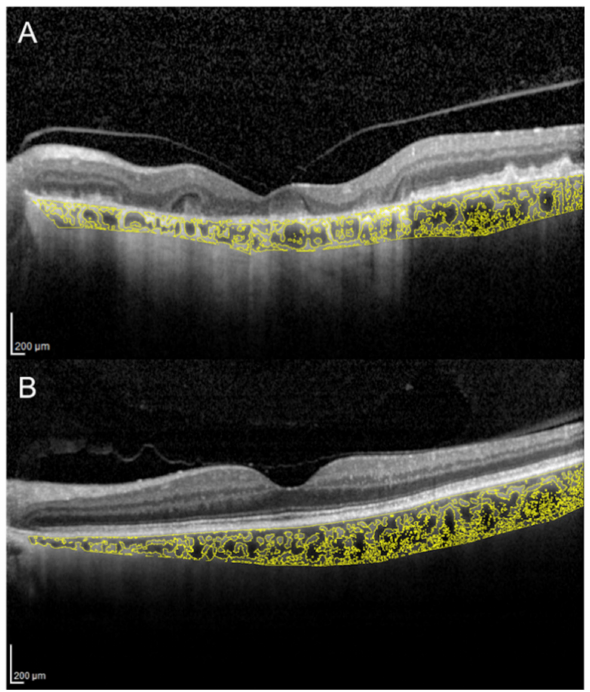
Figure 4. Choroidal vascularity index calculated with the OCT image binarization algorithm in a patient with geographic atrophy ( A ) and in an age-matched healthy subject ( B ) was 61.3% and 65.2%,